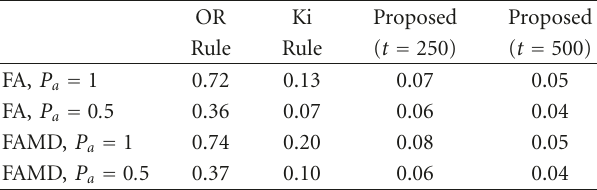
Table 1: False Alarm Rate (when detection rate = 0.99).